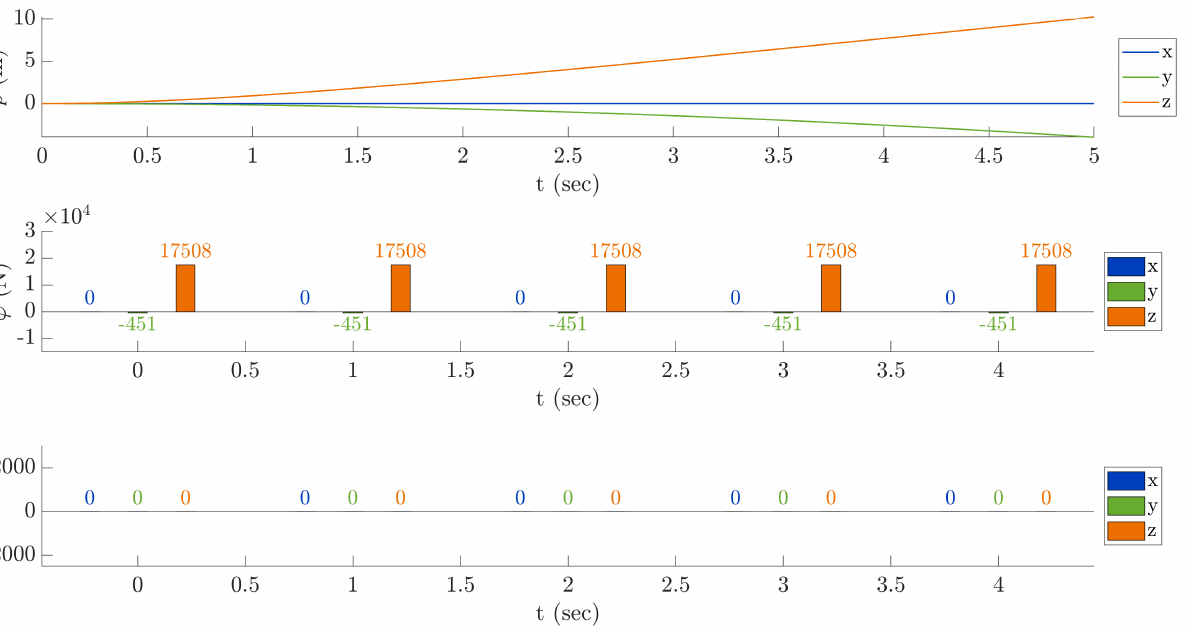
Figure 12. Second test—no